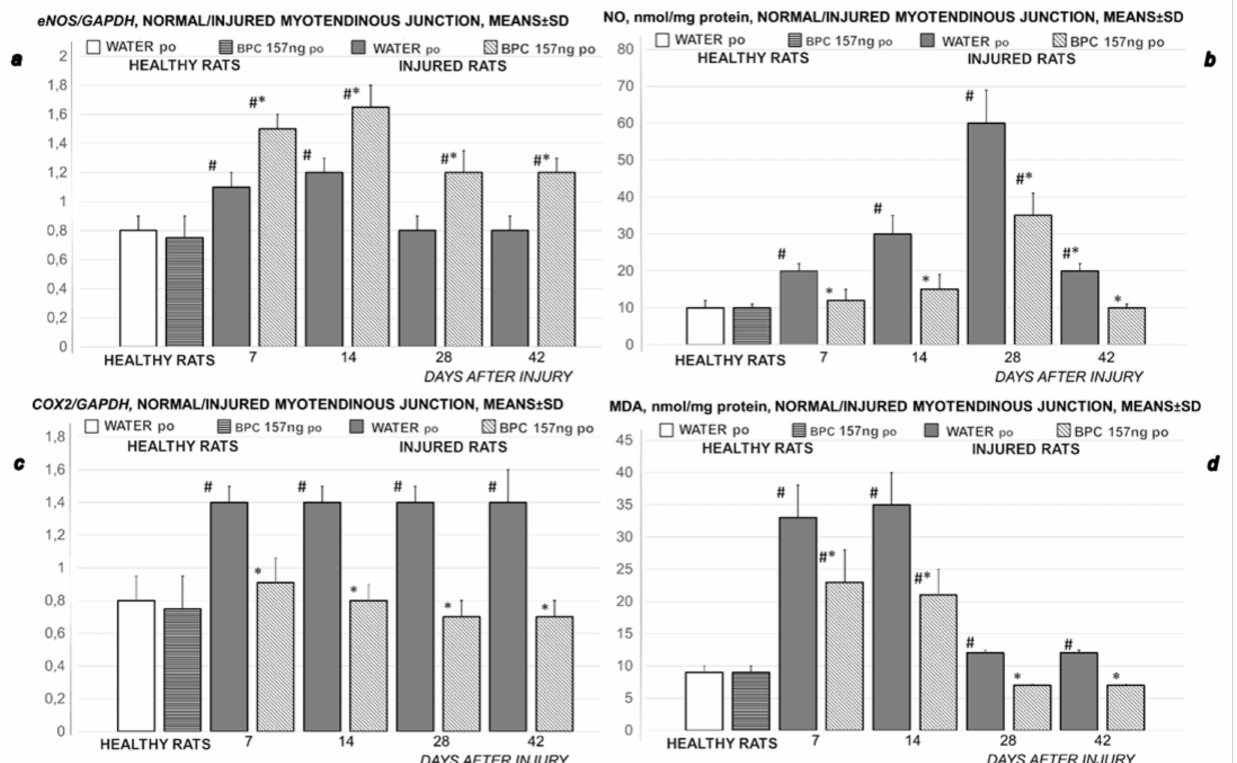
Figure 15. Rats with the disabled myotendinous junction, expression of eNOS mRNA ( a ), NO-level ( b ), expression of COX-2 mRNA ( c ) and MDA-level in the disabled myotendinous junction ( d ), means ± SD, at 7, 14, 28, and 42 postoperative days. Medication (BPC 157 10 ng/kg) was applied perorally in drinking water (0.16 ng/mL, 12 mL/rat/day) while controls received drinking water (12 mL/rat/day) till the sacrifice, at 7, 14, 28 and 42 postoperative